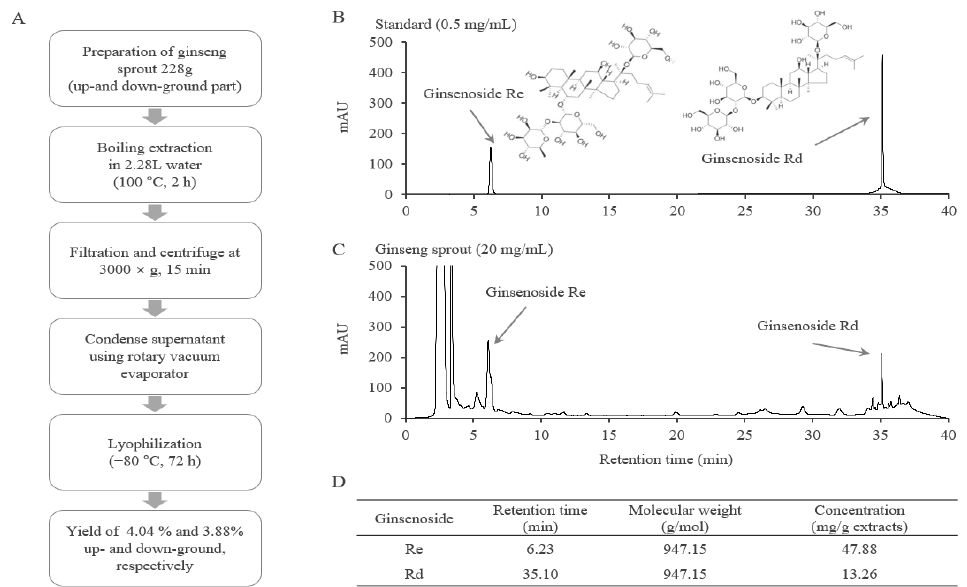
Figure 1. Extract preparation and fingerprinting analysis of GSE. GSE was acquired by water extraction from Panax ginseng sprouts ( A ). GSE ( B ) and reference compounds ( C ) were analyzed by high-performance liquid chromatography (HPLC). The concentrations of Re and Rd in the GSE were calculated according to standards ( D ).